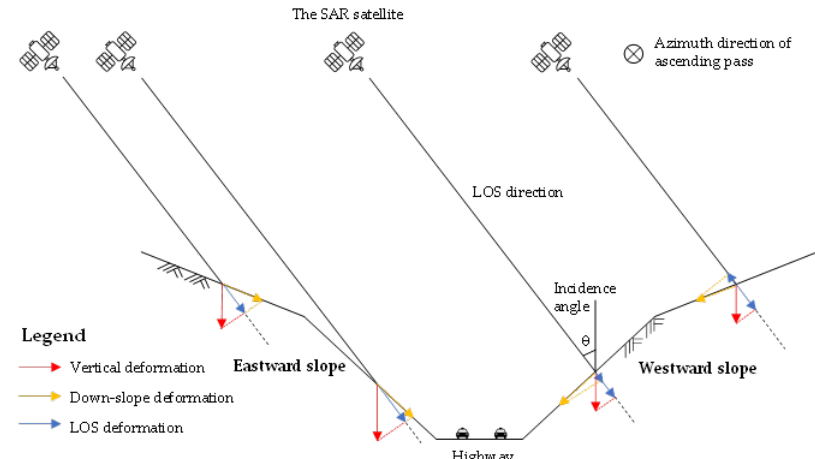
Figure 10. Ground deformation decomposition illustration.